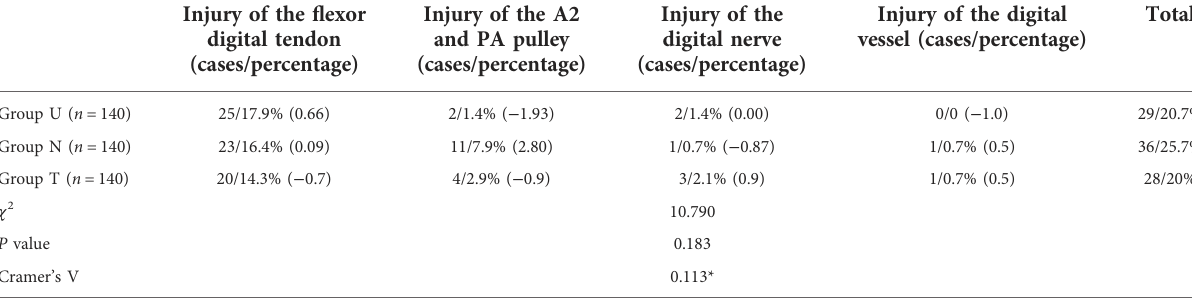
TABLE 1 The injury cases and injury rate of three groups.